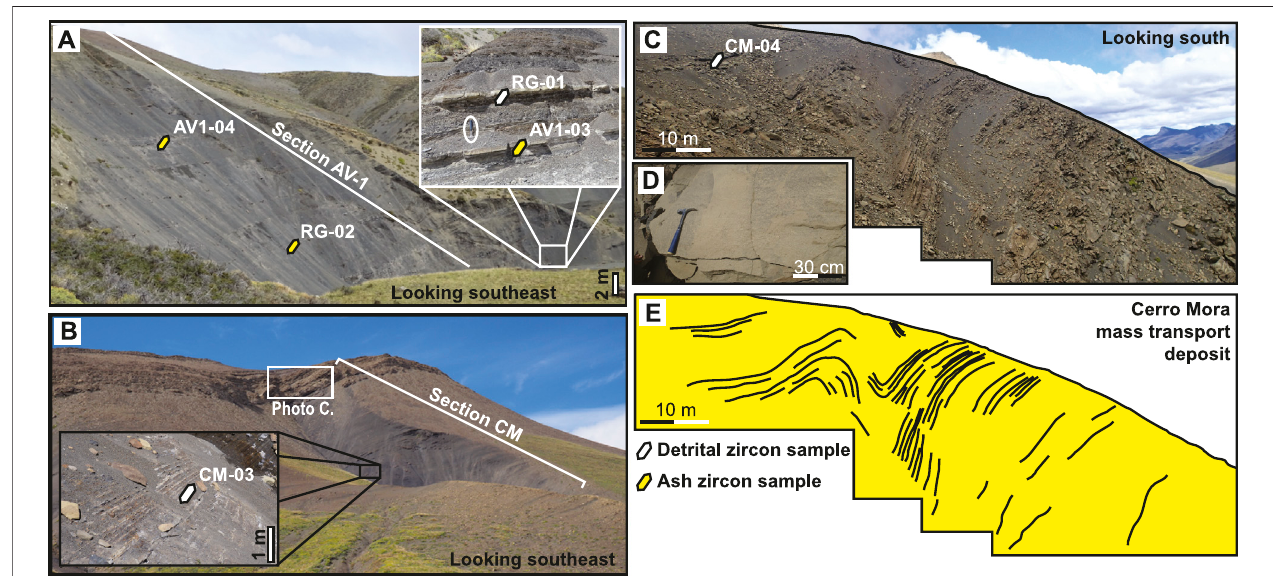
FIGURE 9 | Photographs from described Alta Vista Formation sections. (A) Outcrop scale photograph of section AV-1. Note the predominance of gray thin- bedded mudstone making up this section. Inset image provides an enhanced view of the strata as well as sample locations for samples AV1-03 and RG-01. (B) Photograph of Cerro Mora ( Figure 3A ). Note the thick bedded, buff colored sandstone beds capping the section. Inset image shows an example of strata lower in section CM, which still contains abundant thin-bedded sandstone units. (C) Outcrop scale photograph of the top portion of section CM. Note the abundance of thick-bedded, amalgamated sandstone beds. (D) Exampleofa typical sandstone bed that makes the upper portion ofsection CM. These sandstone units aremassive, fi ne-grained, and occasionally contain water-escape features reminiscent of high-density turbidite deposits (cf. Lowe, 1982). (E) Trace drawing interpretation of contorted and folded stratigraphy in photograph (C) . Note the isoclinal anticline and syncline pair de fi ning the summit of Cerro Mora. We interpret this large fold to be a part of a mass transport deposit associated with submarine landsliding.